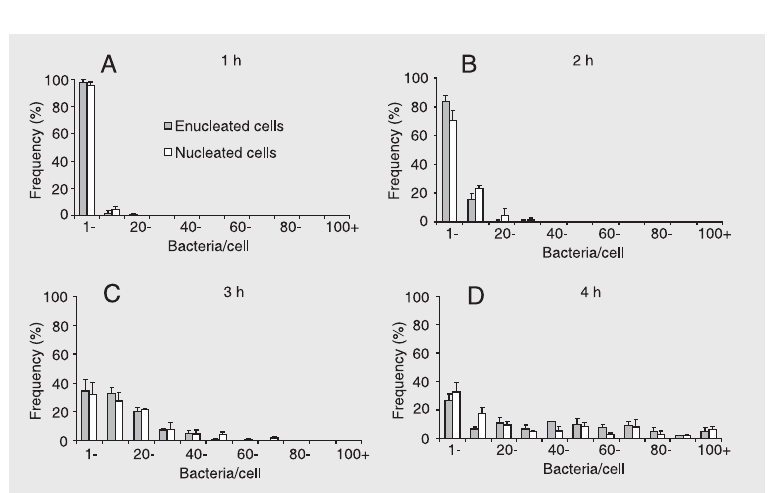
Figure 2. Effect of enucleation on the infection of L929 fibro- blasts with Shigella flexneri . Per- cent infection and numbers of bacteria in cytoplasts and nucle- ated cells are reported as means ± SEM for 3 experiments as a function of time. Cells were in- fected as described in the text. In A , time was not a statistically significant source of variation in the infection of cytoplasts and nucleated cells. However, at all times the % infection of cyto- plasts was significantly lower than that of nucleated cells (P < 0.05, two-way ANOVA). In B , the time factor was a significant source of variation of bacteria per cell, whereas the presence of the nucleus was not (*P < 0.05, two-way ANOVA).